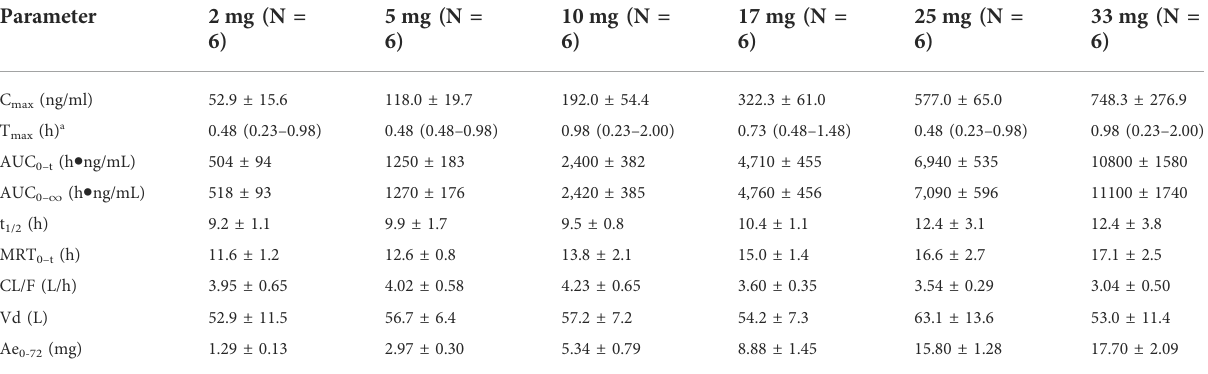
TABLE 2 The primary pharmacokinetic parameters of WXFL10203614 in the single-dose study.